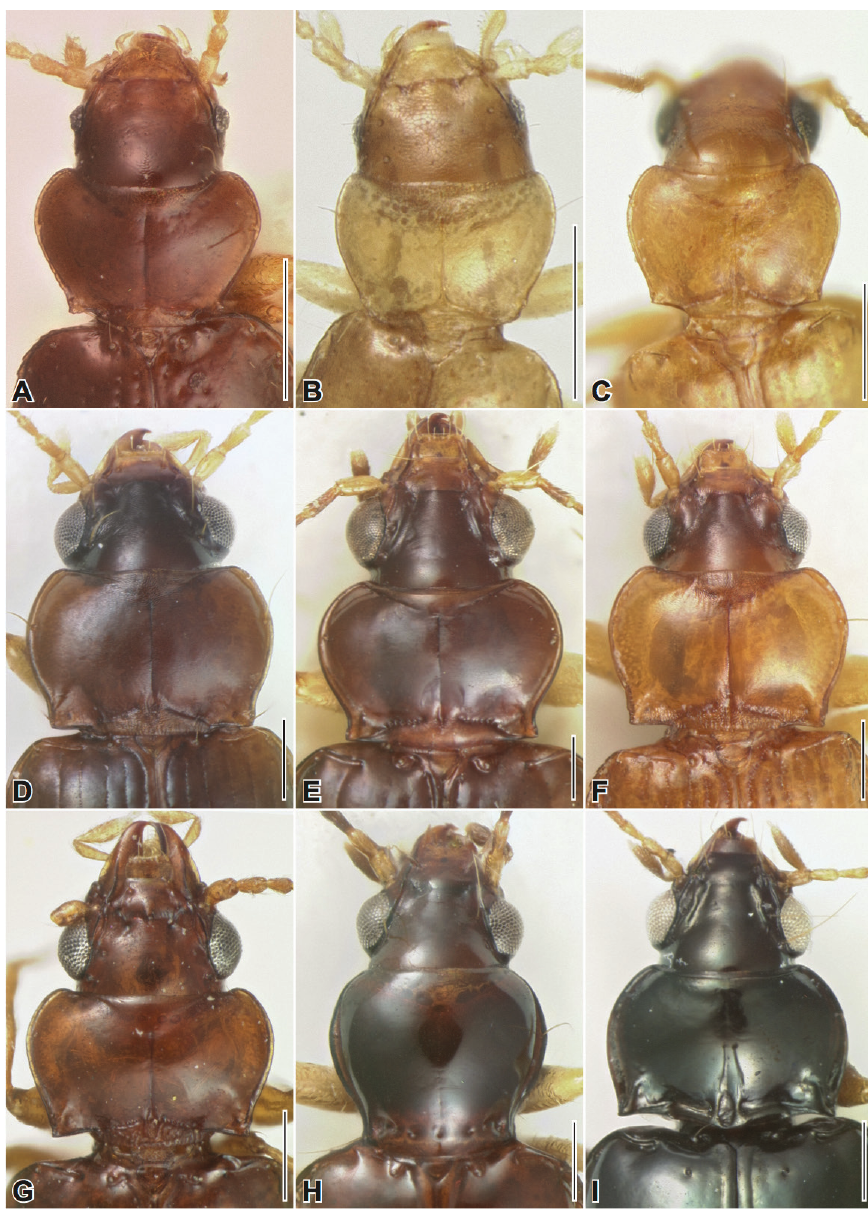
Figure 3. Pronotum, dorsal aspect. A Stigmatachys uvea (holotype, ♀ ), Perú, Loreto, Campamento San Jacinto B Polyderidius sp., México, San Luis Potosí C Nothoderis rufotestacea , USA, Arizona, Cochise Co. D Meotachys ( Hylotachys ) ballorum (paratype, ♀ ), Brazil, Amazonas, Tapurucuara E Elaphropus ( Ammot- achys ) marchantarius (paratype, ♂ ), Venezuela, San Carlos de Rio Negro F Meotachys ( Scolistichus ) riparius (paratype, ♀ ), Brazil, Amazonas, Rio Solimões, Ilha de Marchantaria; G Elaphropus ( Idiotachys ) acutifrons (holotype, ♀ ), Brazil, Santarem H Elaphropus ( Nototachys ) occidentalis (paratype, ♂ ), Perú, Madre de Dios, Pakitza I Tachyxysta howdenorum (holotype, ♂ ), México, Chiapas, El Aguacero. Scale bars = 0.25